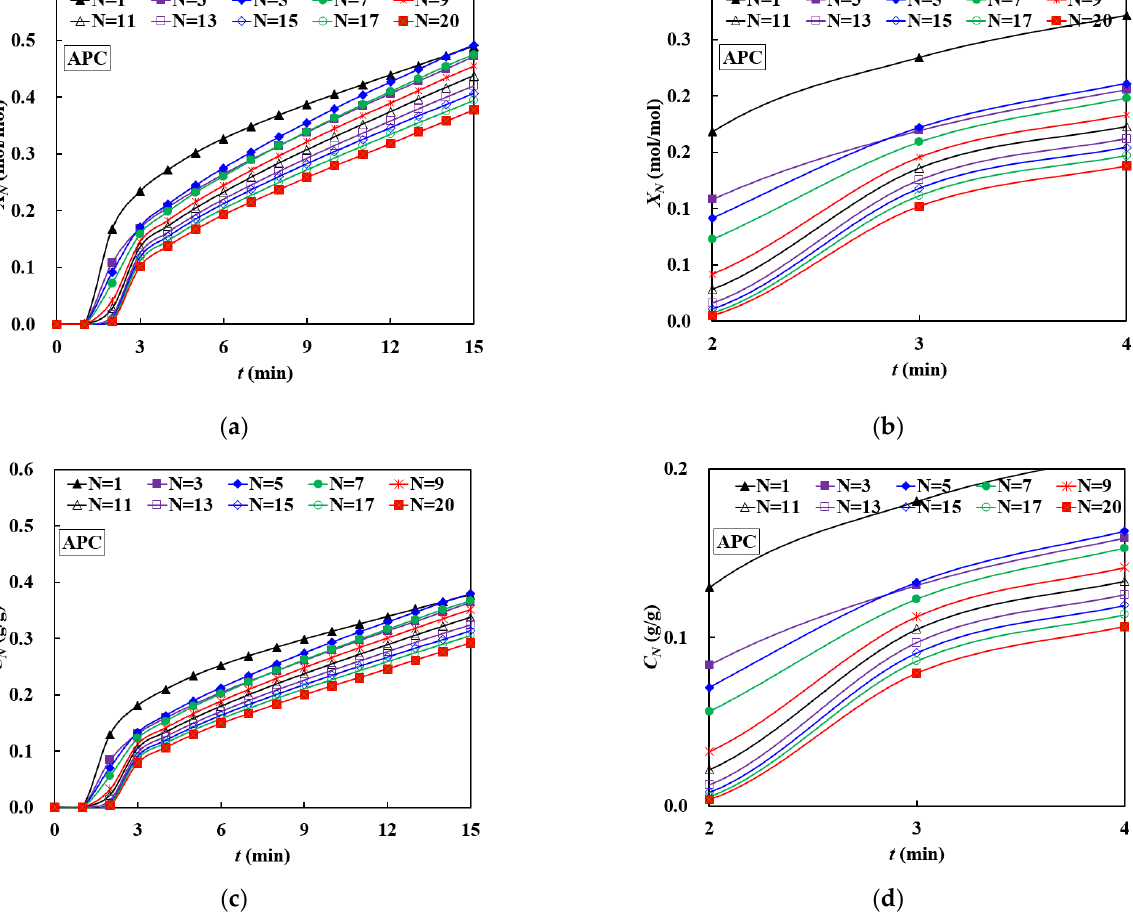
Figure 8. CO 2 capture characteristics of APC during different cycle number: ( a ) relationship between X N and N; ( b ) zoom of ( a ); ( c ) relationship between C N and N; ( d ) zoom of ( c ).